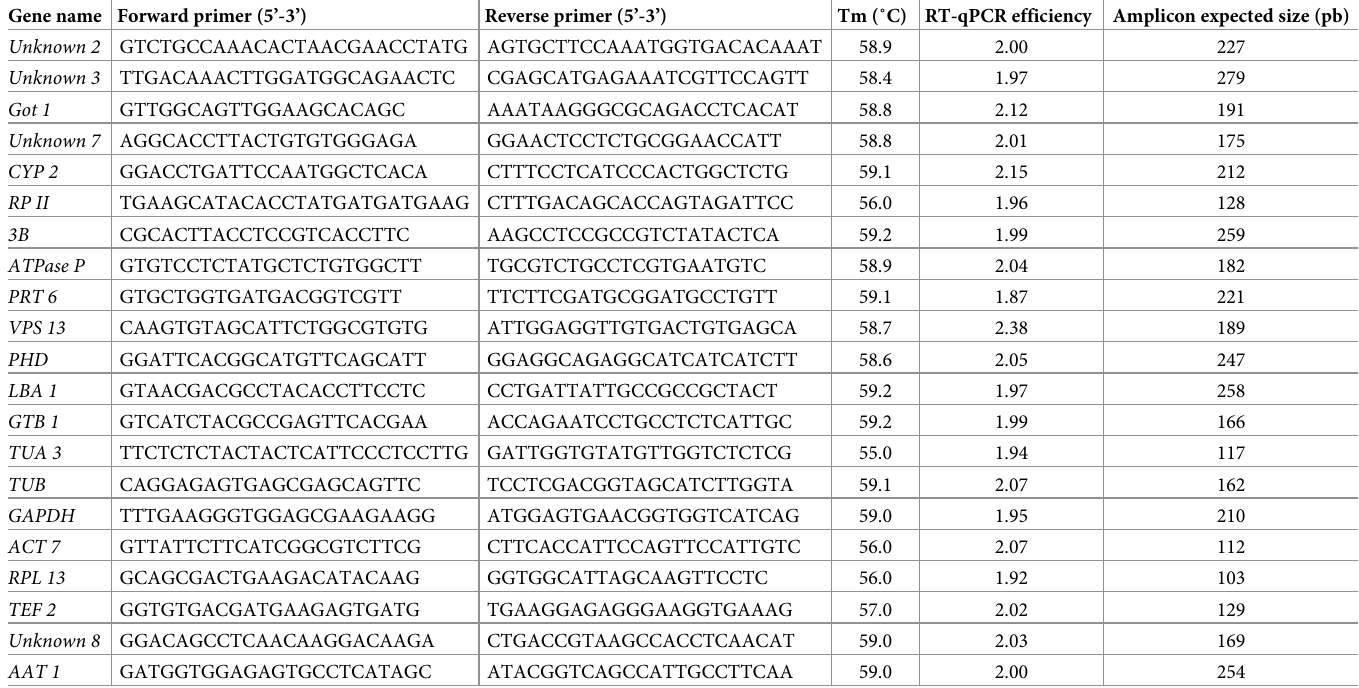
Table 2. Primer sequences, RT-qPCR efficiency and amplicon size for each housekeeping gene studied. Gene name Forward primer (5’-3’)